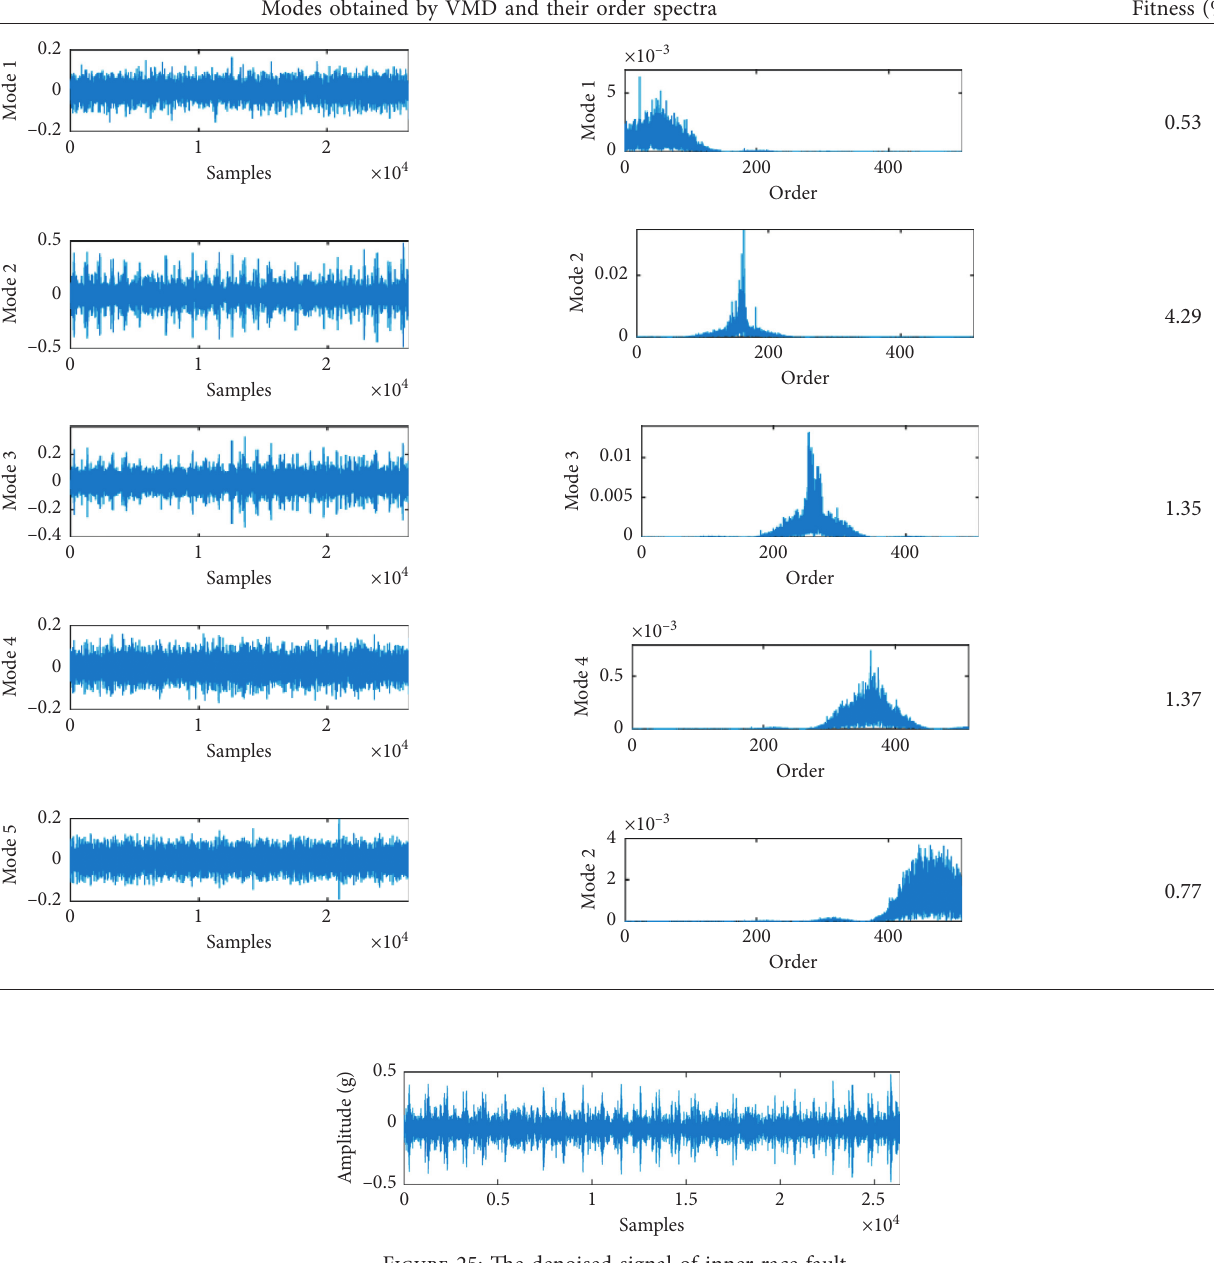
Figure 25: The denoised signal of inner race fault.